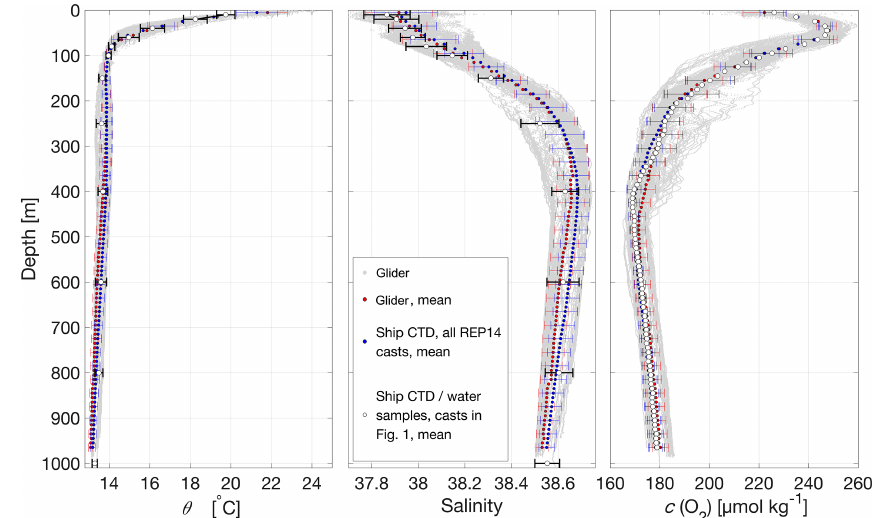
Figure 6. A comparison between the measurements retrieved by the glider and those obtained by the ship CTD package. The binned means (red) calculated using glider measurements (grey) are compared with the binned means of the CTD casts obtained from the entire REP14- MED observational domain (blue) and the binned mean values obtained from water samples (SBE oxygen optode sensor for dissolved oxygen concentrations ( c (O 2 )) during the eight CTD casts in Fig. 1 (white) for (a) potential temperature ( θ ), (b) salinity, and (c) c (O 2 ). Standard deviations (calculated for every 10m bin) are displayed as error bars in this figure every 30m for glider and CTD measurements and at every sampled depth for water samples.